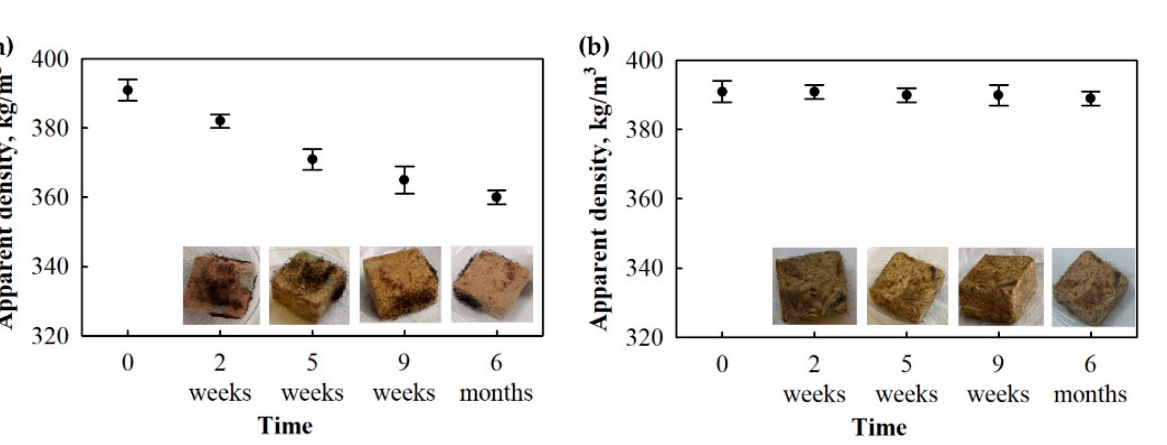
Figure 7. BcB samples after incubation of P. putida and Rh. oryzae mix at 22 °C temperature and 65% relative air humidity conditions for 6 months: ( a ) F composition, ( b ) G composition. All measurements were performed in triplicates, and the average values and standard deviations are shown.